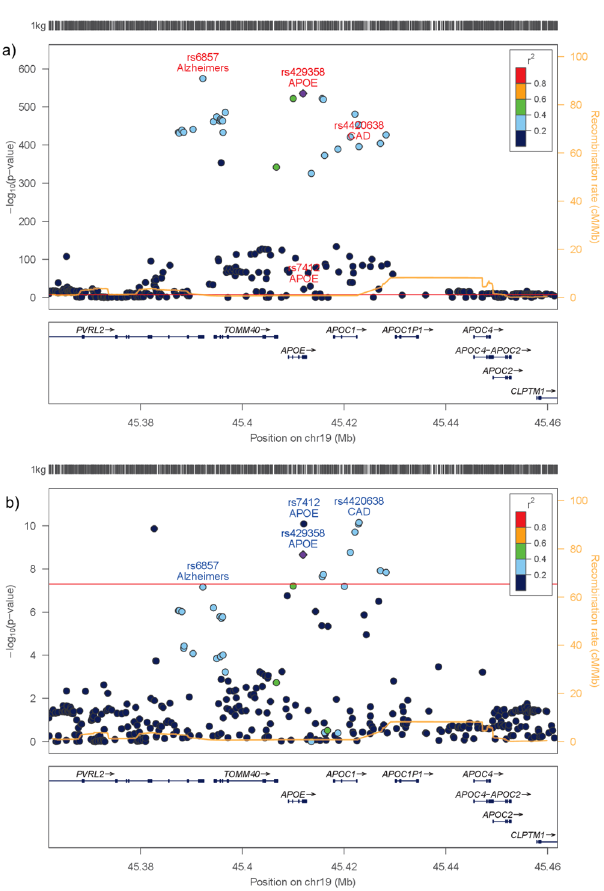
Figure 2. Signal plots of the APOE locus for LOAD and CAD. ( a ) LocusZoom 42 signal plot of the APOE locus from the IGAP cohort. The strongest signal detected was for rs6857. Peak variant for CAD (rs4420638) and the APOE ε 2 (rs7412) and ε 4 (rs429358) variants are included. ( b ) Signal plot of the APOE locus from the CARDIoGRAM plus C4D meta-analysis. The strongest association signal detected was for rs4420638. Peak variant for LOAD (rs6857) and the APOE ε 2 (rs7412) and ε 4 (rs429358) variants are included. LD structure in both plots is in reference to the APOE ε 4 (rs429358)